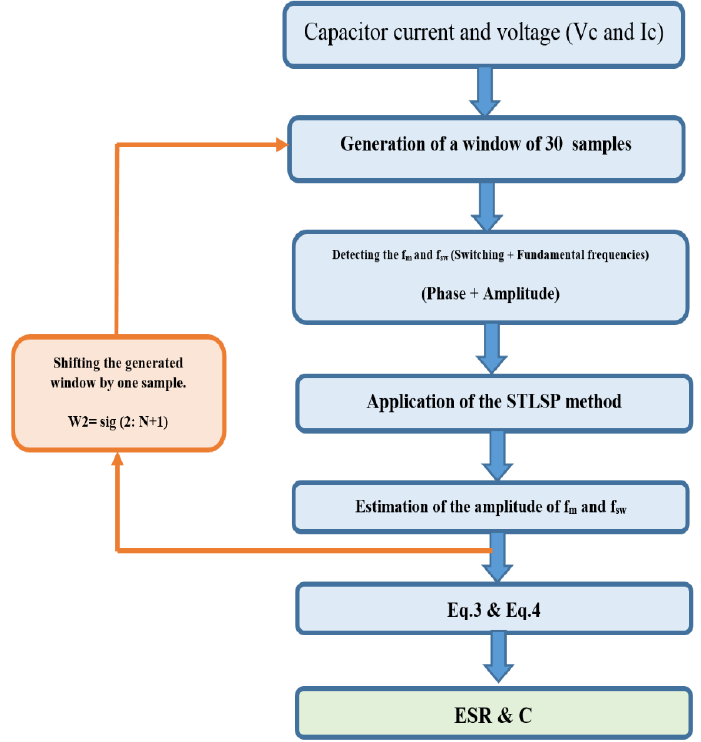
Figure 6. The proposed FDA.